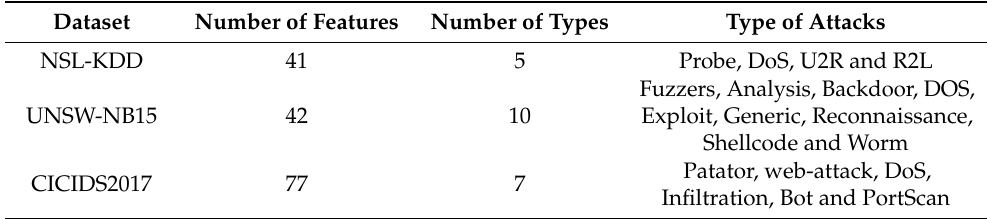
Table 1. A brief summary of the NSL-KDD, UNSW-NB15 and CICIDS2017 datasets.